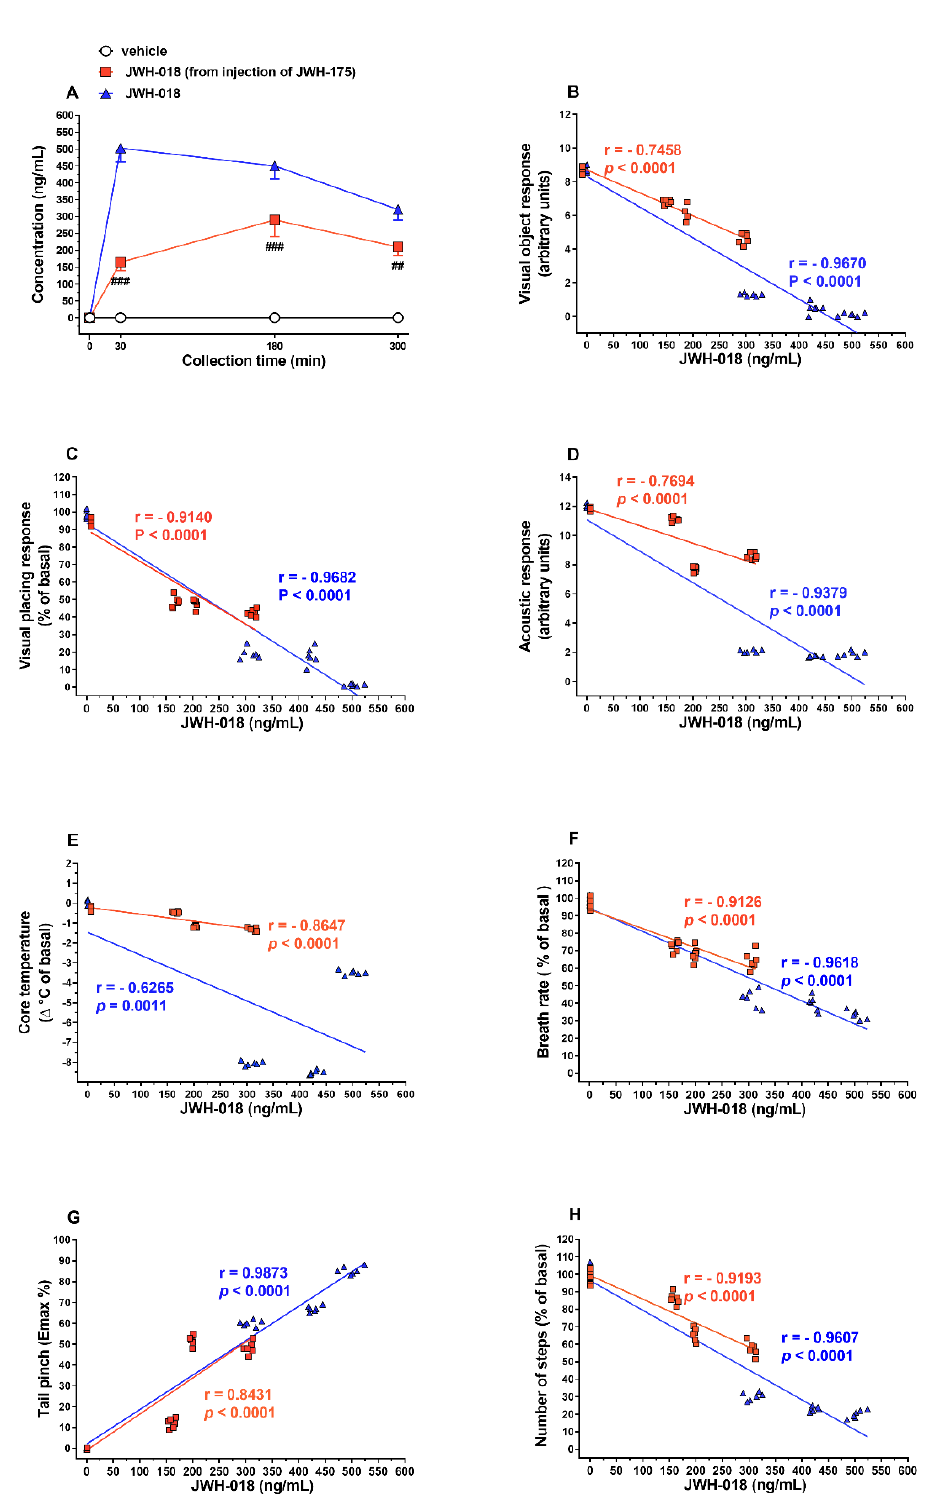
Figure 8. Concentration of JWH-018 in the plasma of mice detected at 30, 180, and 300 min after the injection of JWH-175 (10 mg/kg i.p.) and JWH-018 (10 mg/kg i.p.; ( A )). Results are expressed as ng/mL and represent the mean ± SEM of 6 samples for each time point. Correlation between visual object ( B ), visual placing ( C ) and acoustic ( D ) responses, body temperature ( E ), breath rate ( F ), mechanical analgesia ( G ), and motor activity ( H ) changes with JWH-018 plasma concentrations. Correlation coefficients were determined by performing Pearson’s correlation calculation. ## p < 0.01, ### p < 0.001 versus JWH-018.